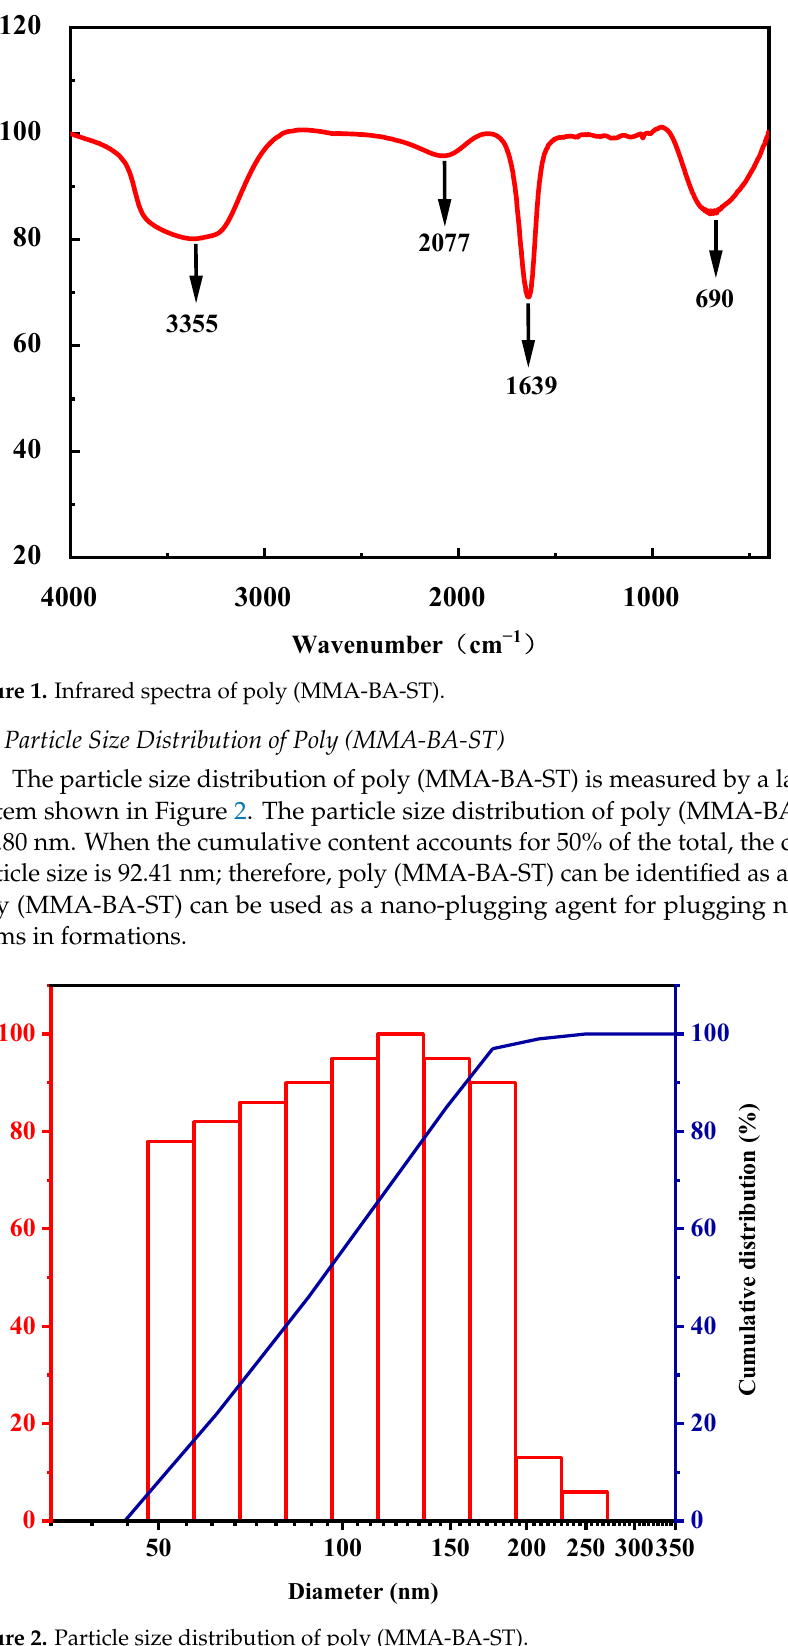
Figure 2. Particle size distribution of poly (MMA-BA-ST).